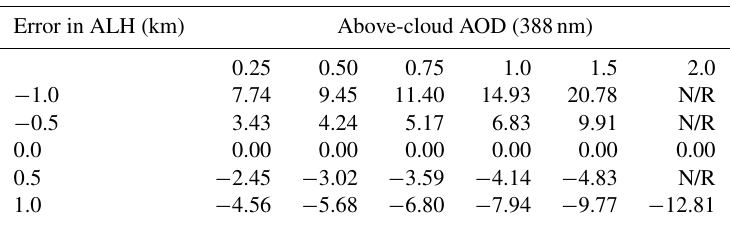
Table 4. Theoretical error (%) in ACAOD (388nm) due to the uncertainty in the assumption of aerosol layer height (ALH). The reference value of ALH assumed in the calculation was 4.0km; the error in ALH (leftmost column) represents perturbation from the reference value. The cloud optical depth underneath the aerosol layer was assumed to be